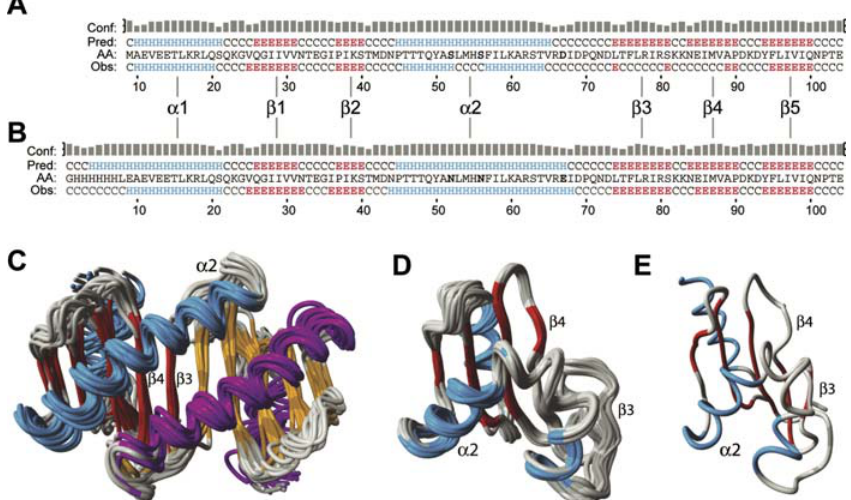
Figure 1. Sequence and Structure Ensembles of Two DLC2A Structures (A) The sequence of human DLC2A (hDLC2A) (AA). (B) The sequence of mouse DLC2A (mDLC2A) proceeded by an eight-residue His-tag (AA). The secondary structure as predicted using PSIPRED [33,50] (Pred) and the confidence of this prediction (Conf) are shown above the sequences. The secondary structure as observed in the ensembles (Obs) is indicated below the sequences. Except for the His-Tag, the mouse and human sequences differ at three positions (indicated in bold). (C) Ribbon diagram of the structure ensemble of mDLC2A (PDB entry 1Y4O). The residues of the His-tag have been omitted for clarity. (D) Ribbon diagram of the structure ensemble of hDLC2A (PDB entry 1TGQ). (E) The refined average structure of the ensemble calculated using the reconstructed 1TGQ dataset, as discussed in the text. Secondary structure is indicated using colors: helices are shown in blue and purple, strands are shown in red and orange. A numbering scheme for the secondary structure elements is indicated between the two sequences. DOI: